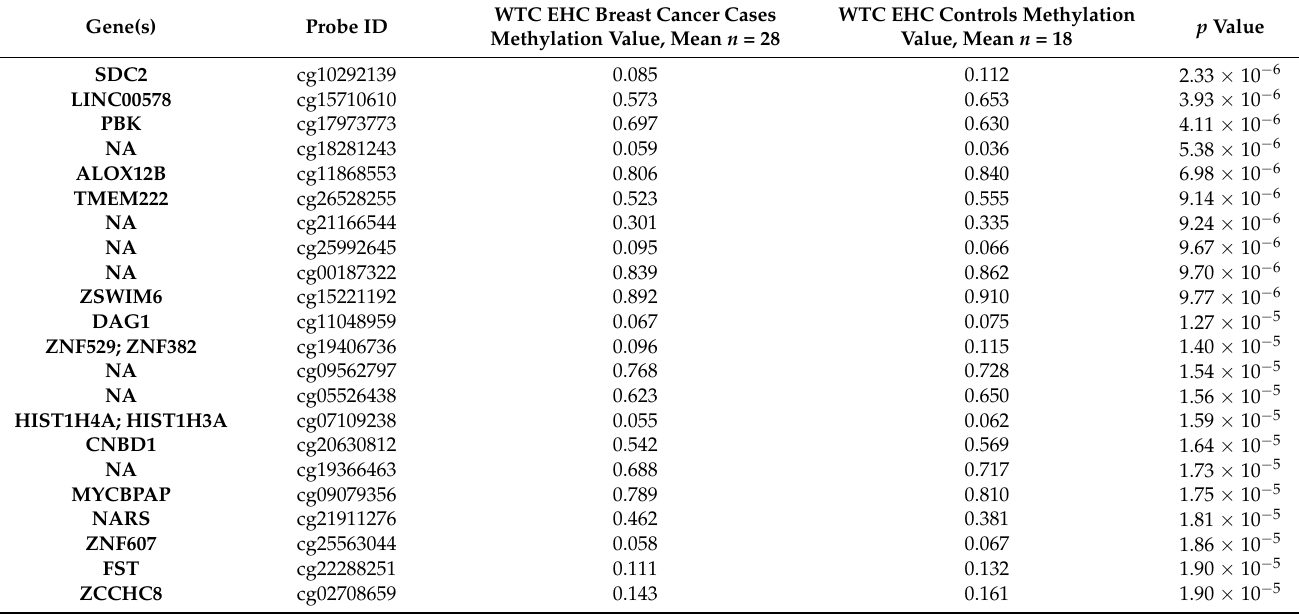
Table 4. Top differentially methylated probes, and top 15 gene-associated probes, comparing WTC- exposed (WTC EHC) breast cancer cases vs. WTC EHC cancer-free women.